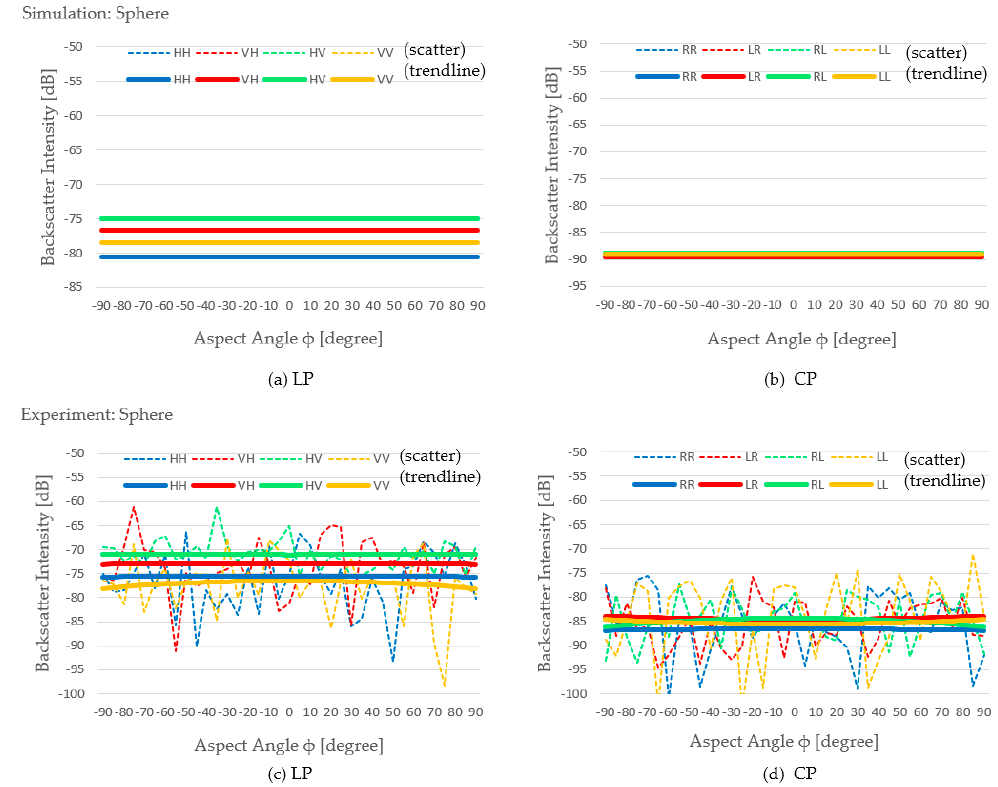
Figure 13. Backscatter intensity of a medium-sized sphere ( d / λ = 6.8): ( a ) Simulation result of LP, ( b ) simulation result of CP, ( c ) experimental result of LP, and ( d ) experimental result of CP.